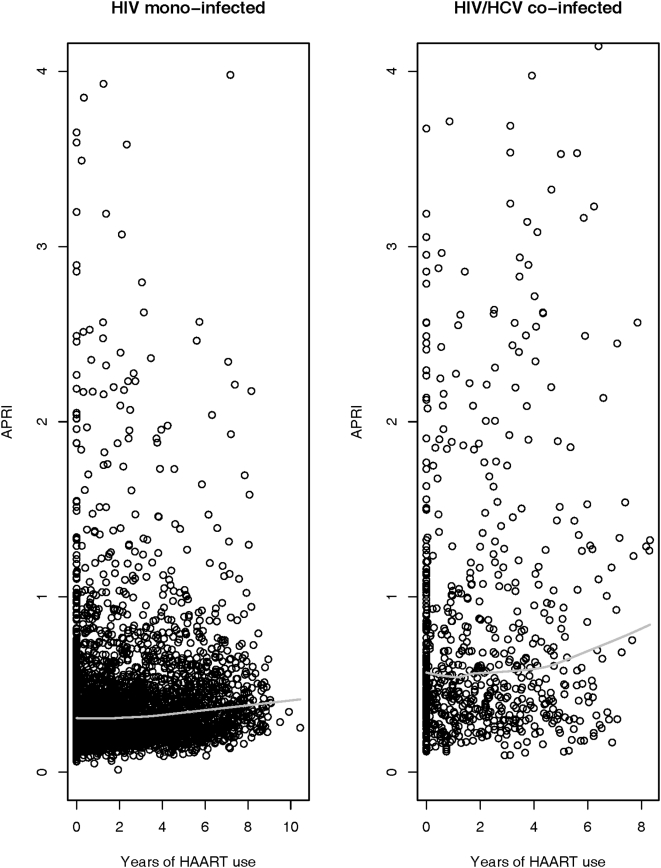
APRI by cumulative HAART exposure in years over the course of the study.The figure on the left is HIV-infected and on the right is the HIV/HCV co-infected patients; 15 data points in mono-infected persons and 39 points in co-infected persons have APRI scores above 4.0.